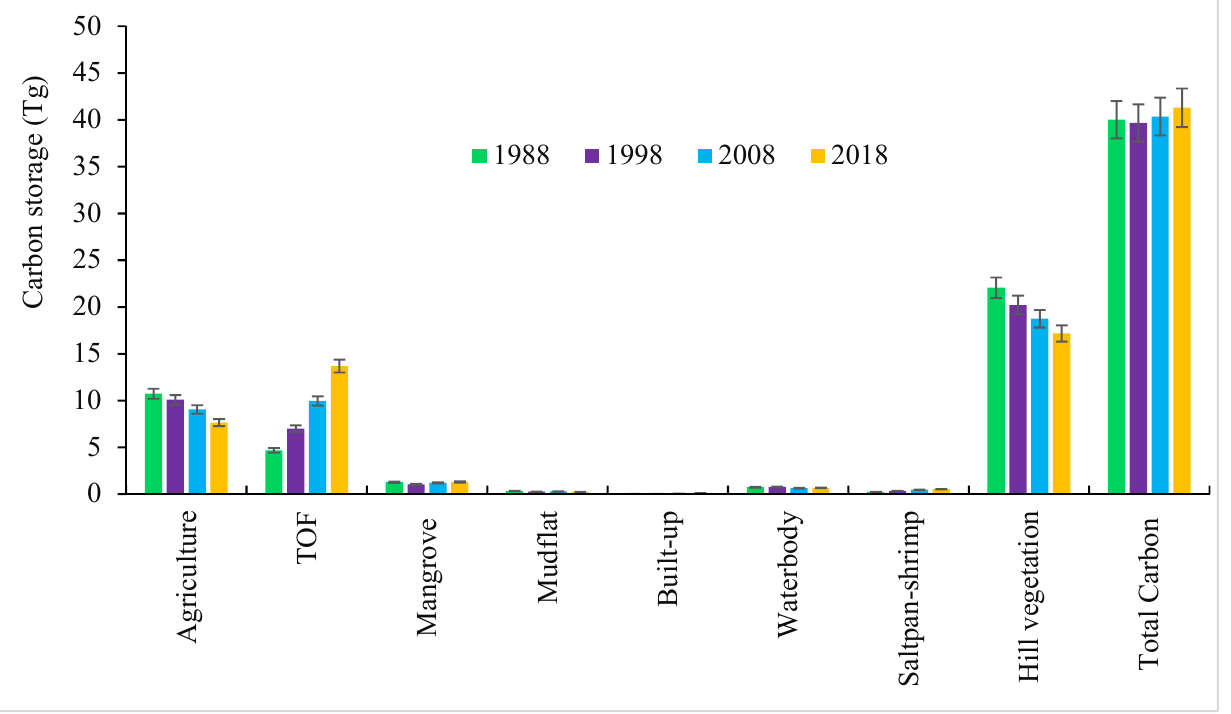
Figure 6. Carbon storage by different land biomes in the eastern coast of Bangladesh over 1988–2018.